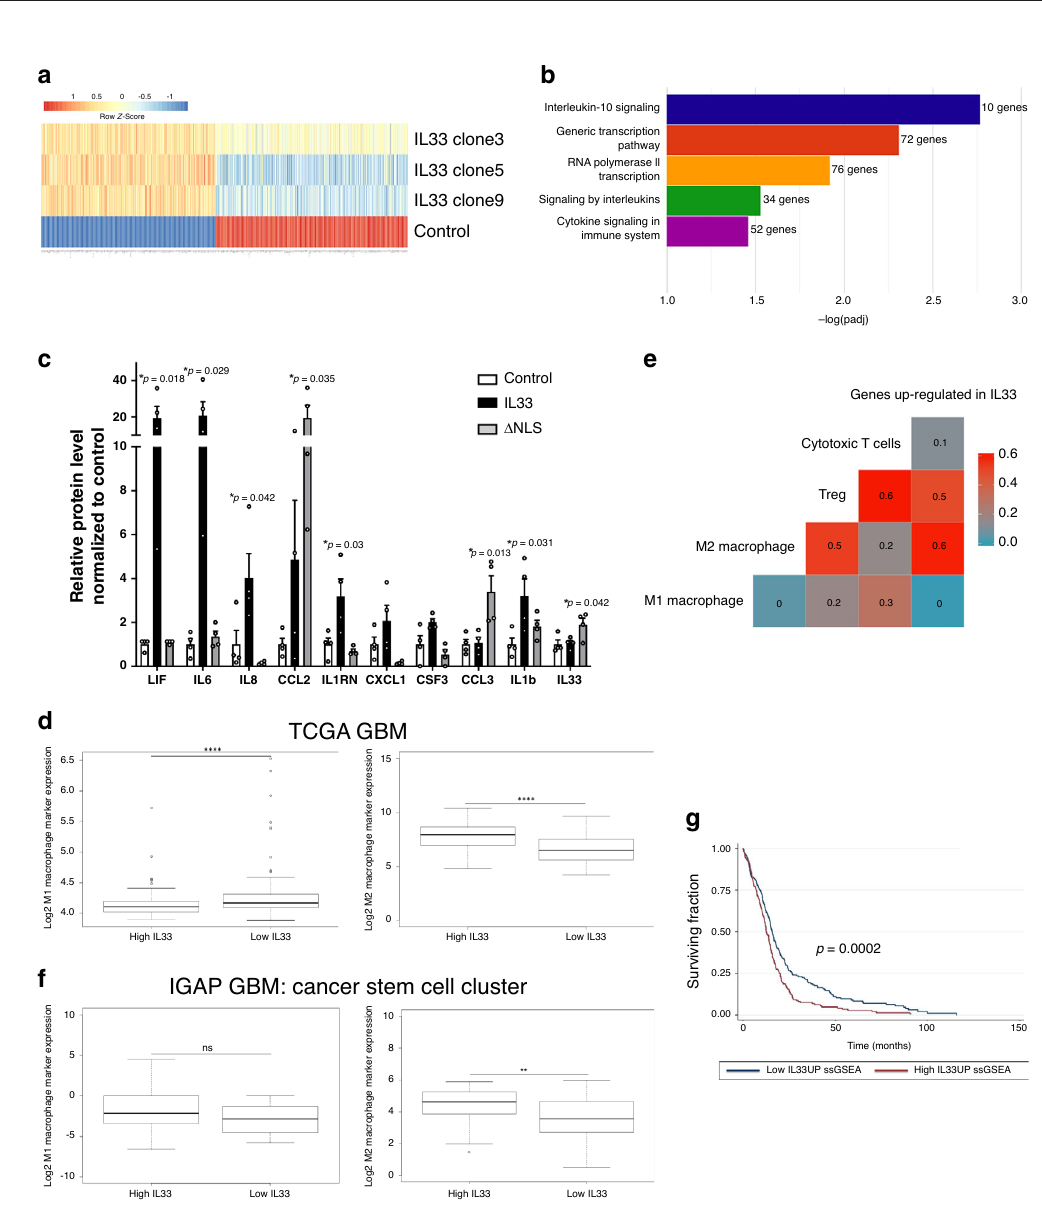
Fig. 3 Nuclear IL-33 is required for tumor growth and macrophage in fi ltration. a Diagram of full-length and mutant IL-33 constructs. Full-length IL-33 consists of a nuclear localization domain (green), chromatin-binding motif (CBM; purple), an activation domain (blue), and an IL-1 like cytokine domain (red). Deletion mutant ( Δ NLS) lacks the nuclear domain. IL-33 western blot of U87-IL-33 (clones 3 and 9), Δ NLS (clones 3 and 4), or pcDNA3.1 vector (control) detect full-length IL-33 (33 kDa) in cell lysates and a 25 kDa secreted form in the conditioned medium. Actin was used as a loading control. N = 3 experiments. b Immuno fl uorescence for nuclear IL-33 (green) in control, IL-33, or Δ NLS transfected U87 cells 24 h after treatment with leptomycin B (50 nM). Scale bar, 20 µ m. c Mice implanted with pcDNA (control), IL-33, and Δ NLS-expressing U87 were sacri fi ced at 3 weeks, when IL-33 mice became symptomatic. Second cohort was sacri fi ced at 6 weeks postinjection. Shown are representative images of IHC (brown) for h-nucleolin, Iba1, and IL-33. Experiment was repeated fi ve times ( N = 5 mice per group/experiment). Sections were counterstained with hematoxylin (blue). Scale bar, 2 mm; inset scale bar, 25 µ m. d Kaplan – Meier survival curve of animals bearing U87-control ( N = 14), IL-33 (clone 3, N = 10; clone 9, N = 10), or Δ NLS (clone 3, N = 3; clone 4, N = 3) tumors from three independent experiments. The p -value was calculated using log-rank Mantel – Cox test. Control vs. IL-33 clones 3 or 9, **** p ≤ 0.0001; IL-33 clone 9 vs. Δ NLS clone 3, ** p = 0.0054. e Quanti fi cation of CD11b + Gr1 − macrophage in control ( N = 3) and IL-33 ( N = 3) tumors using fl ow cytometry. PBS-injected mice were used as sham control ( N = 4). Graph shows the normalized counts of CD11b + Gr1 − cells per million total events. Data are mean ± SEM; ** p ≤ 0.01, **** p ≤ 0.0001 by one-way ANOVA with Tukey ’ s post hoc test. f Syngeneic K1492 glioma cells expressing IL-33 or empty vector (control) were allowed to grow for 10 days when IL-33 + mice became symptomatic. Representative H&E and Iba1 (brown) IHC images are shown. Experiment was repeated fi ve times ( N = 5 per group/experiment). Sections were counterstained with hematoxylin (blue). Scale bar, 1 mm; inset scale bar, 50 µ m. g Kaplan – Meier survival curve of animals bearing control ( N = 15) or IL-33 ( N = 18) tumors from three independent experiments. The p -value was calculated using log-rank Mantel – Cox test (control vs. IL-33, p = 0.0477). See also Supplementary Fig. 3. Source data are available as a Source data fi